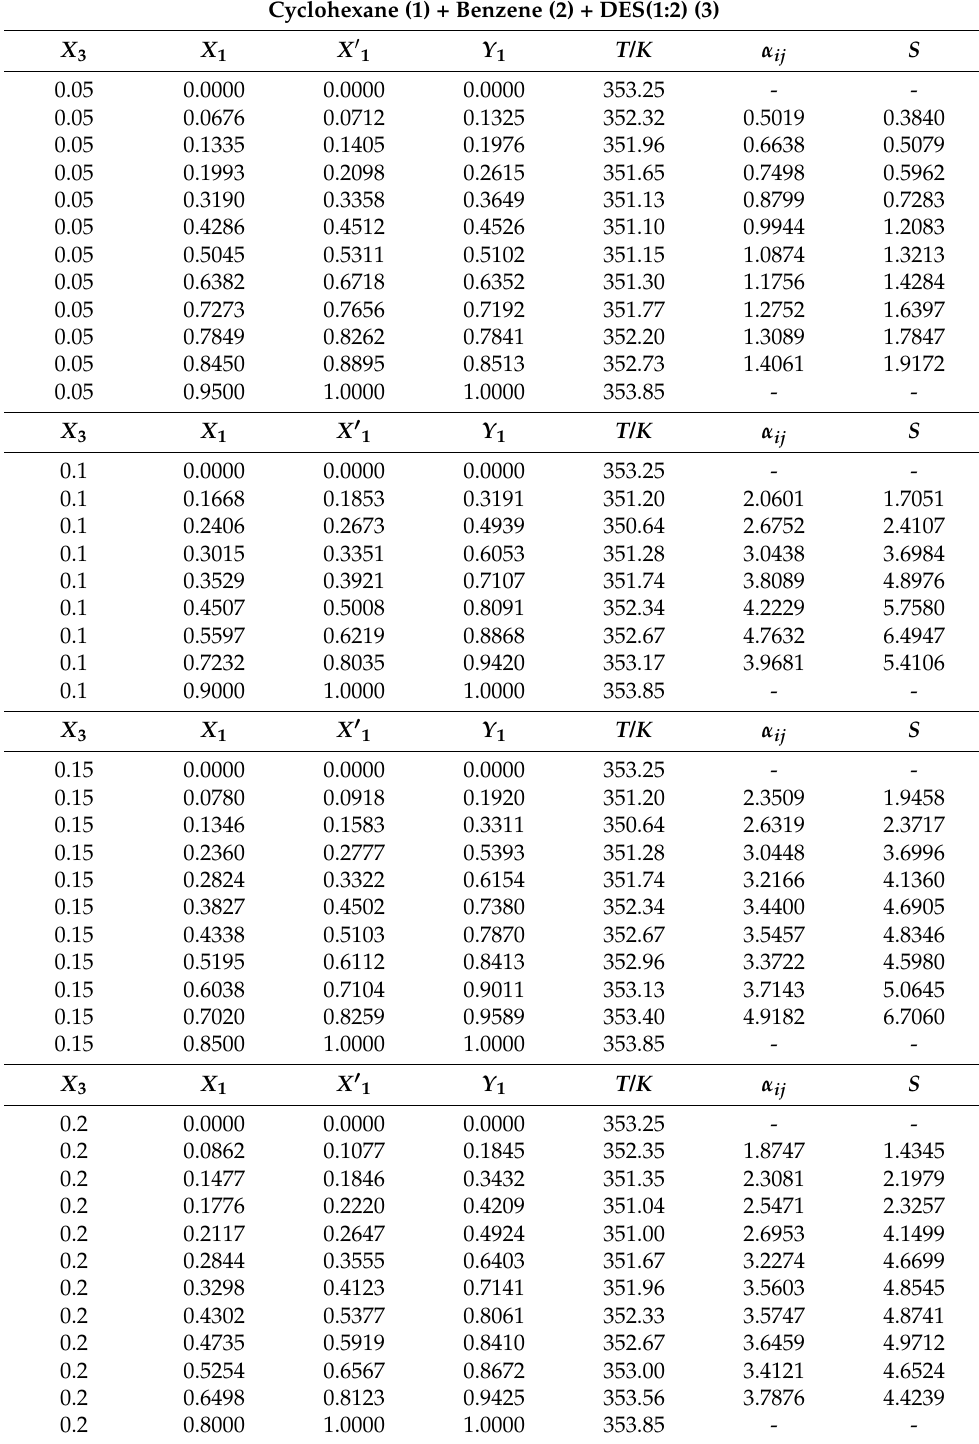
Table 9. Vapor–liquid equilibrium data of the pseudo-ternary systems cyclohexane (1) + benzene (2) + DES(1:2) (3) at a pressure of 101.335